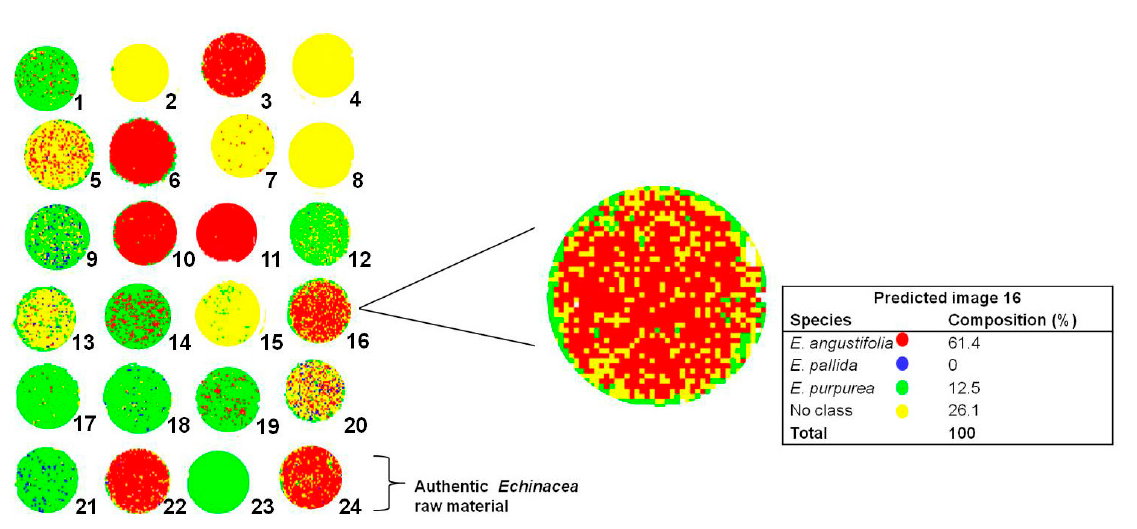
Figure 9. PLS prediction images (t ) of Echinacea commercial products and authentic raw 1 material showing variation in the chemical composition of Echinacea commercial